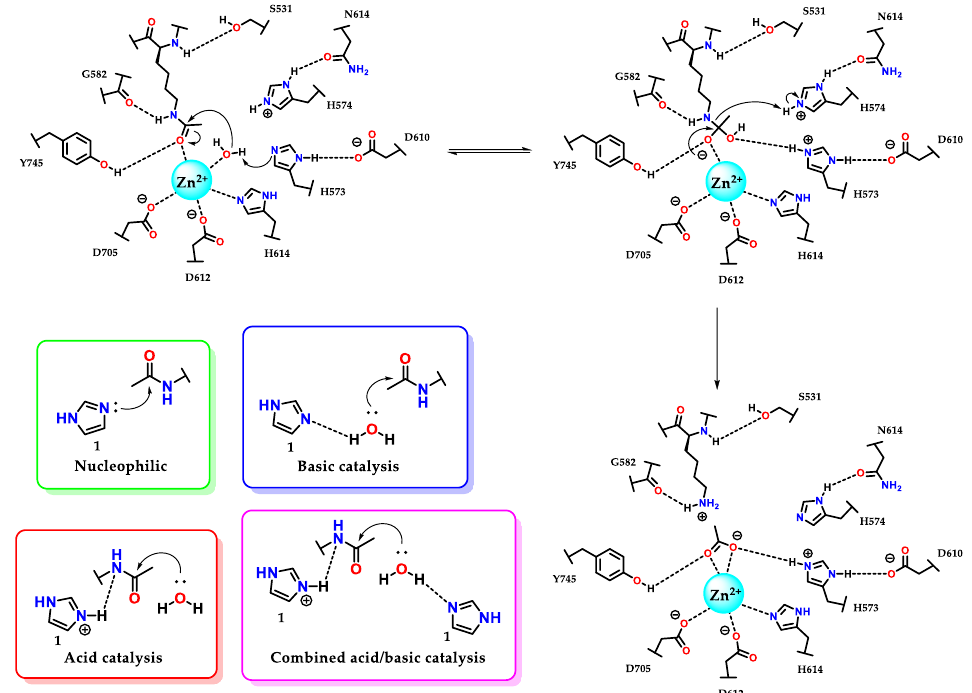
Figure 29. Participation of histidine 7 residues in the deacetylation reaction of lysine residues promoted by enzyme histone deacetylase 6 (HDAC6) and the kinetic profiles of imidazole catalysis.